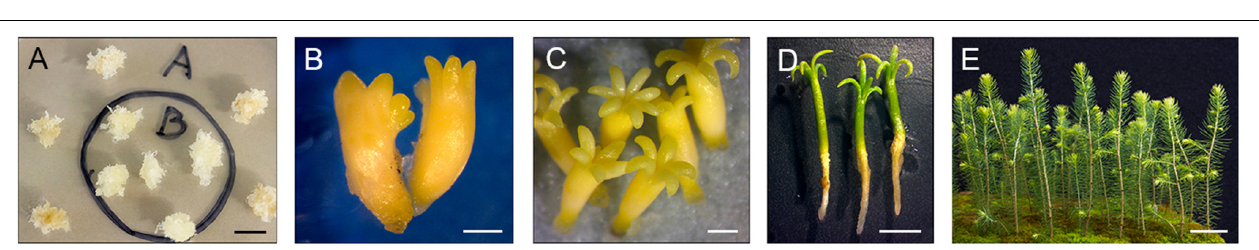
FIGURE 3 | (A) Co-culture of EM of 11Pa3794 genotype ( A , outside circle) and EM 15Pa1029 nurse tissue ( B , inside circle). (B,C) Cotyledonary somatic embryos of 11Pa3794 genotype from different maturation events before and after co-culture with nurse tissue. (D) Germinated somatic embryos from subline of 11Pa3794. (E) Somatic trees of genotype 11Pa4066 after second growing season. Bars: (A) = 1 m, (B) = 50 mm, (C) = 10 mm, (D) = 1 mm, (E) = 50